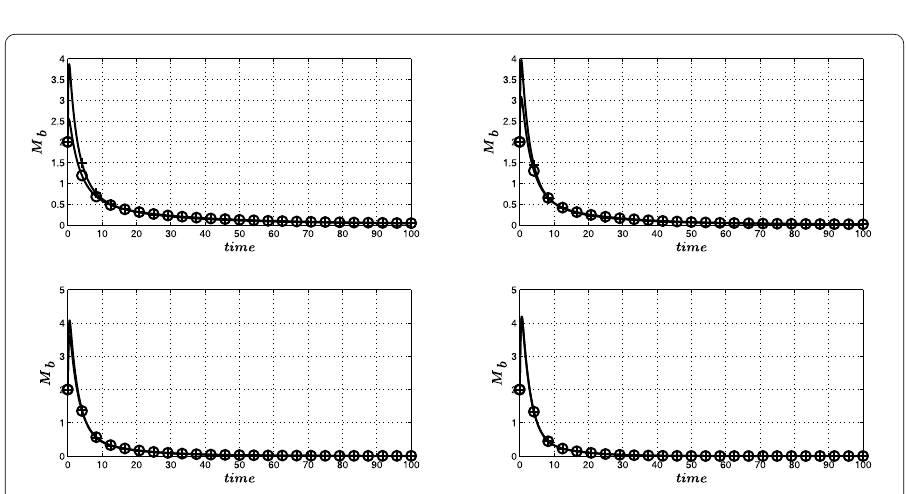
Figure 4 Asymptotic behaviour of M b within the classic Caputo derivative (+) and ABC fractional operator ( (cid:11) ) for different values of α . α = 0.85 (upper-left), α = 0.9 (upper-right), α = 0.95 (lower-left), α = 1